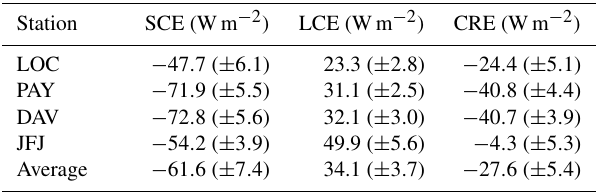
Table 4. Long-term average values of the shortwave and longwave cloud effects (SCE and LCE, respectively), and cloud radiative ef- fect (CRE) for the 1996–2015 period at all four stations. The 1 σ uncertainties are shown in